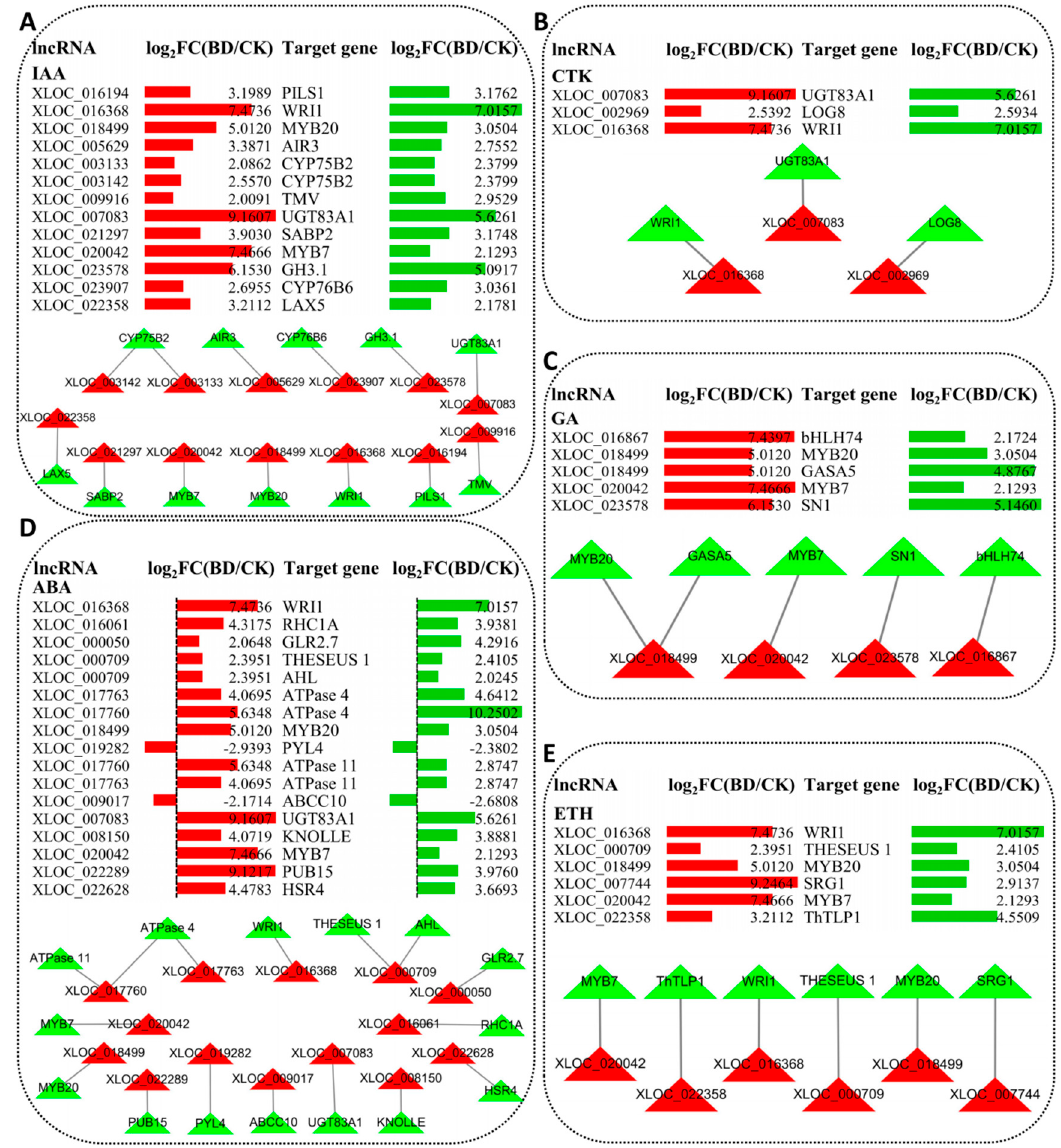
Figure 11. LncRNAs involved in plant hormones biosynthesis and signal transduction. ( A ) Auxin (IAA) relative lncRNAs and their target genes; ( B ) Cytokinin (CTK) relative lncRNAs and their target genes; ( C ) Gibberellin acid (GA) relative lncRNAs and their target genes; ( D ) Abscisic acid (ABA) relative lncRNAs and their target genes; ( E ) Ethylene (ETH) relative lncRNAs and their target genes. Data Bars with di ff erent colors showed the expressions of lncRNAs (colored in red) and target protein-coding genes (colored in green) under boron deficiency conditions, respectively. For the co-expression network, the rectangle nodes represent lncRNAs (colored in red) and protein-coding genes (colored in green), and edges show regulatory interactions among nodes.